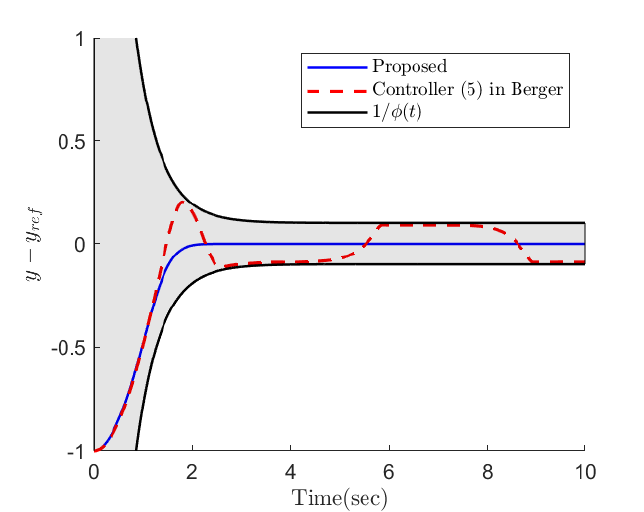
Figure 13. The tracking error in Part 3.